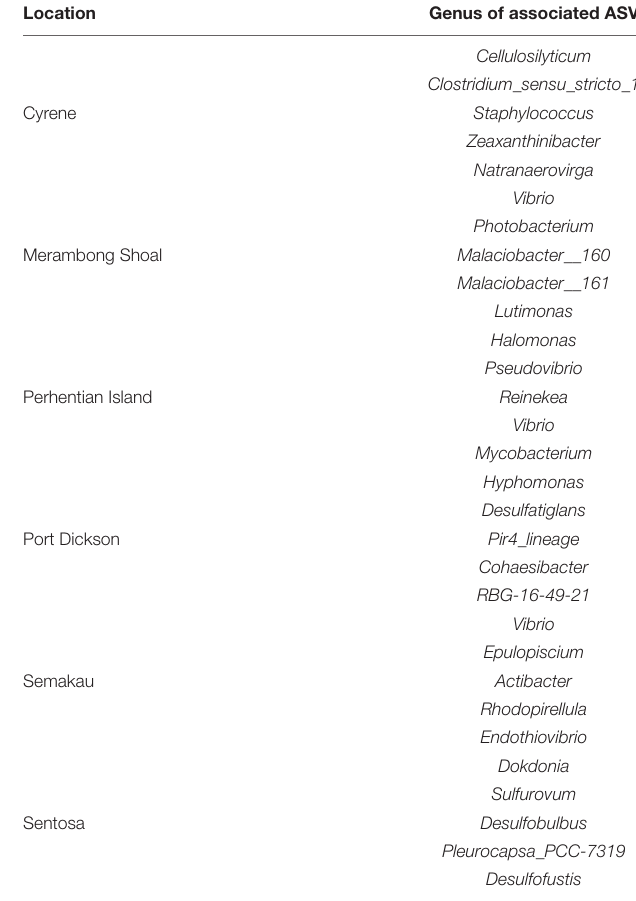
TABLE 2 | Top 5 genera significantly associated with each structure see Supplementary Table 2 for a complete list of significant associations. Structure